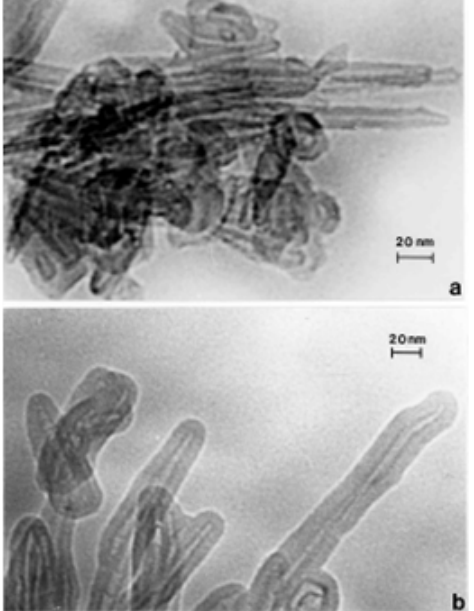
Figure 4: Carbon nanotubes and other carbon nanocrystal polyhedra (a) composing PM aggregates collected on the University of Texas at El Paso, TX, USA campus. Note in (b) the closed multiwall carbon nanotube structures and other fullerene morphologies readily observable at the aggregate edges. The collection site was roughly 100 m from a natural gas-burning power